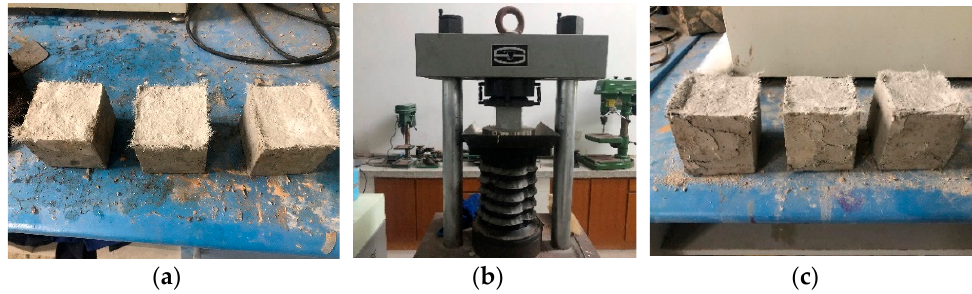
Figure 5. Compressive strength test of HDC. ( a ) Demolding form; ( b ) loading; ( c ) destruction form.